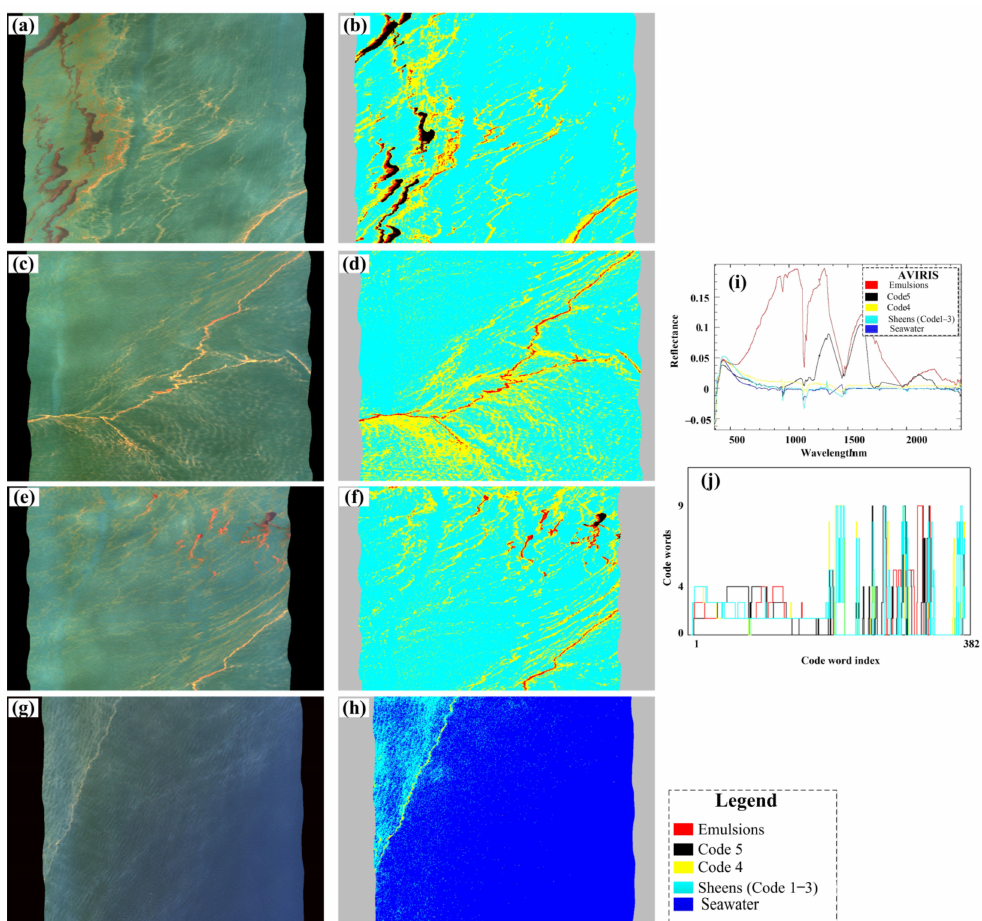
Figure 10. The subareas of the experimental data 6 (( a , c , e , g ), captured by the AVIRIS) and their crude oil leakage detection results produced by the MSE method with SSI ( b , d , f , h ). Subfigures ( i , j ) were the original sample spectra and their encoded results (scale =